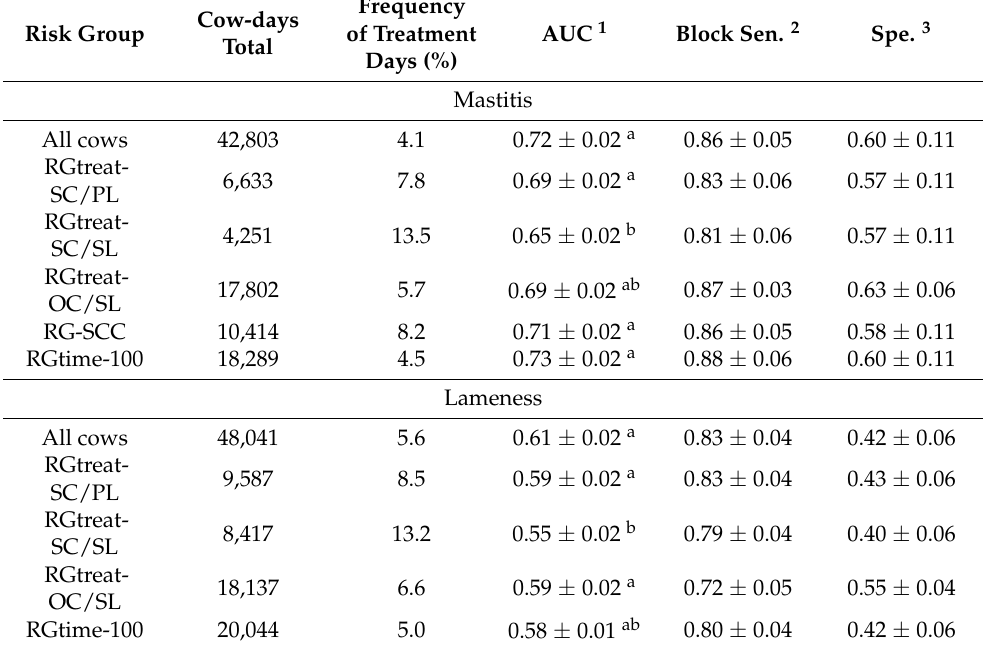
0.58 ± 0.01 ab 0.42 ±